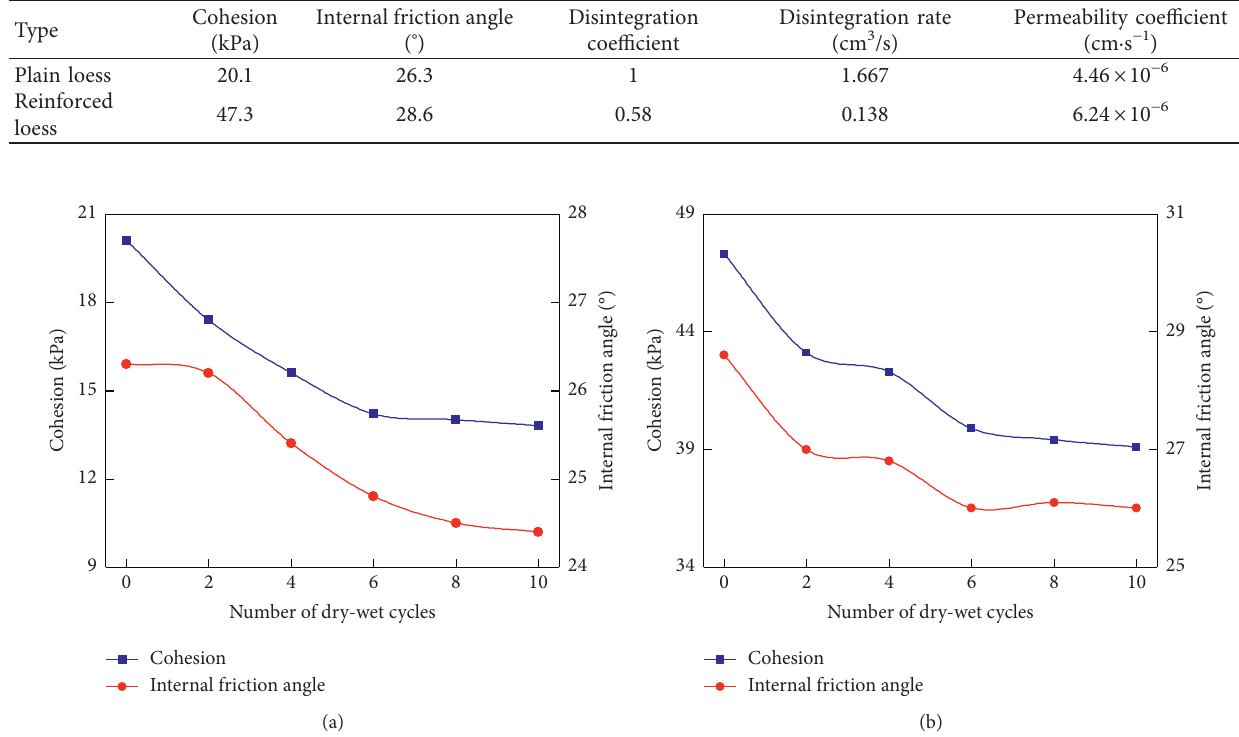
Figure 2: The effects of D-W cycles on strength with the number of cycles: (a) control loess; (b) fiber-reinforced loess.